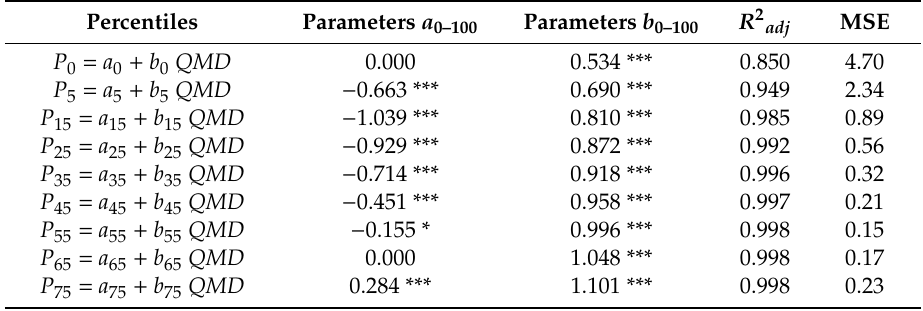
Figure 2. Relationship between percentiles ( P 0 , P 5 , P 15 , ..., P 100 ) and the quadratic mean diameter ( QMD ) of black alder stands. Table 2. Parameters and goodness-of-fit statistics for equations describing relationships between percentiles and the quadratic mean diameter ( QMD ) of black alder stands.